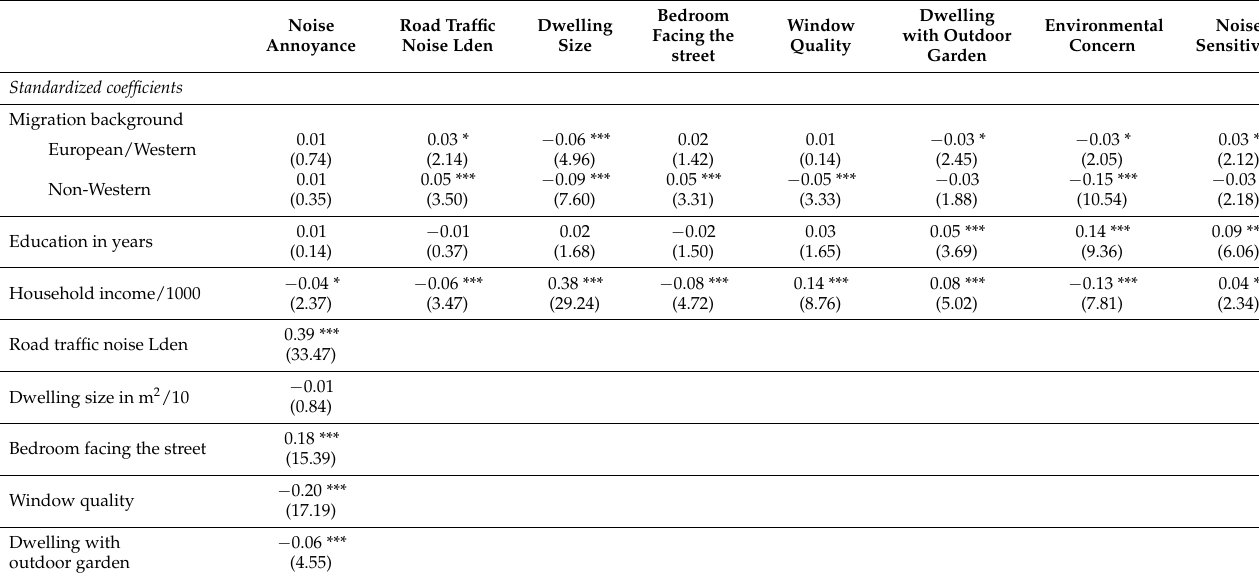
Table A1. Path model of factors affecting annoyance due to road traffic